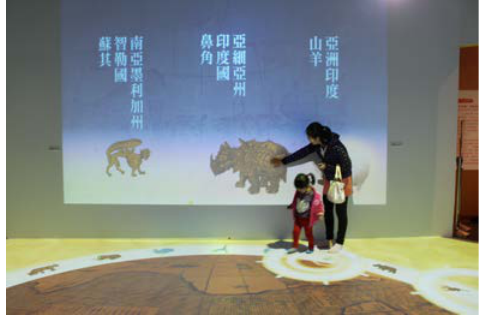
Figure 6. The adult participant is revealing the modern image of the ancient animal by waving her arm while her kid is capturing the exotic animals on the floor with glowing ring at her foot.